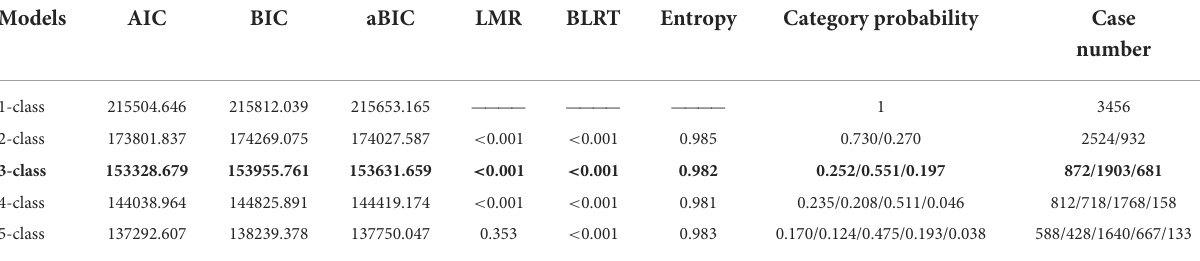
TABLE 2 Model fit indices for different models.